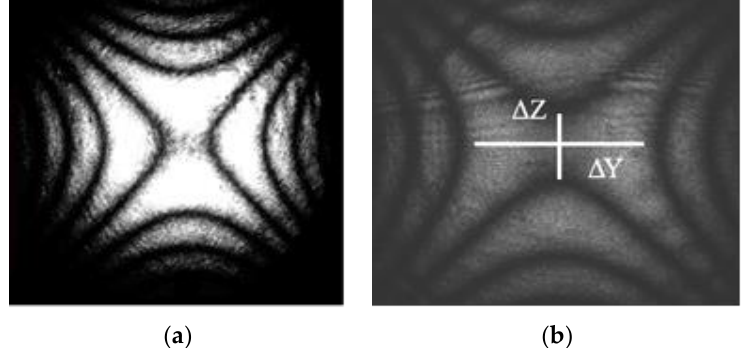
Figure 2. ( a ) Fringe pattern obtained observing a uniaxial crystal sample orthogonally to the optic axis (the X or Y axis in Figure 1d) or a biaxial sample along its obtuse bisector (the X axis in Figure 1e). ( b ) The measurement method for achieving the stress measurement, ( ΔY − ΔZ ) = k 0 + k σ σ .